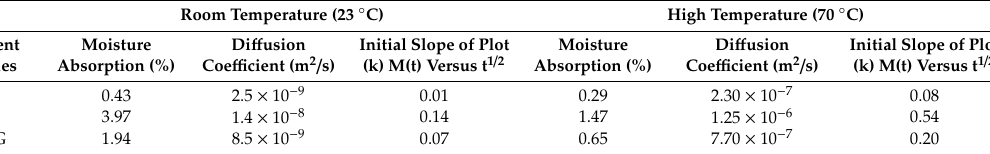
Table 1. Moisture uptake and di ff usion coe ffi cient results.